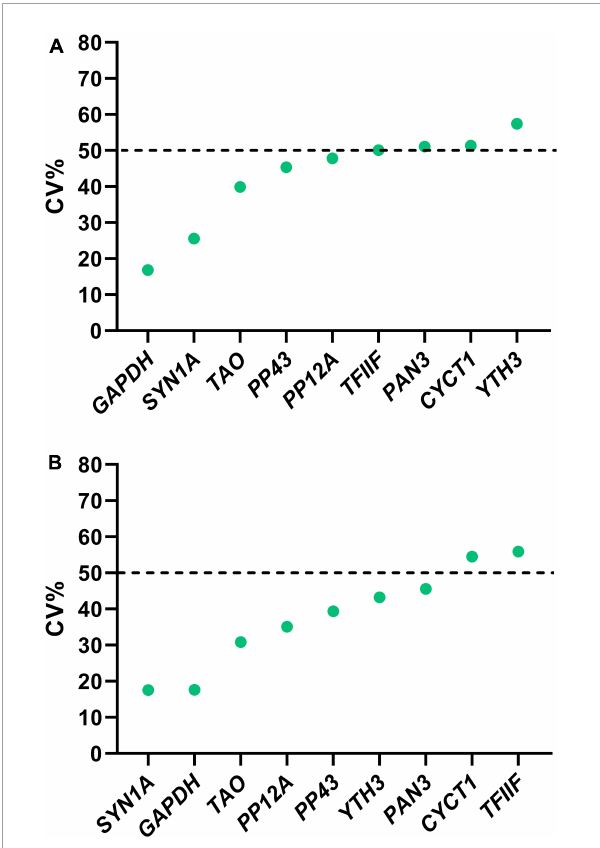
FIGURE3 CV% values for the selected candidate reference genes, calculated on the linearized 2-Ct converted Ct values at all Sitophilus oryzae developmental stages considered in Figure 2 . (A) CV% measured considering all developmental stages. (B) CV% calculated considering only adult stages. Only genes with a CV% lower than 50 were selected for further